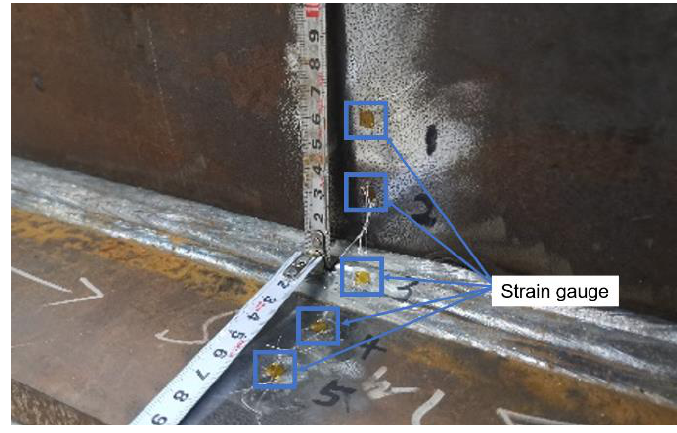
Figure 4. The measurement process of indentation strain gauge method.